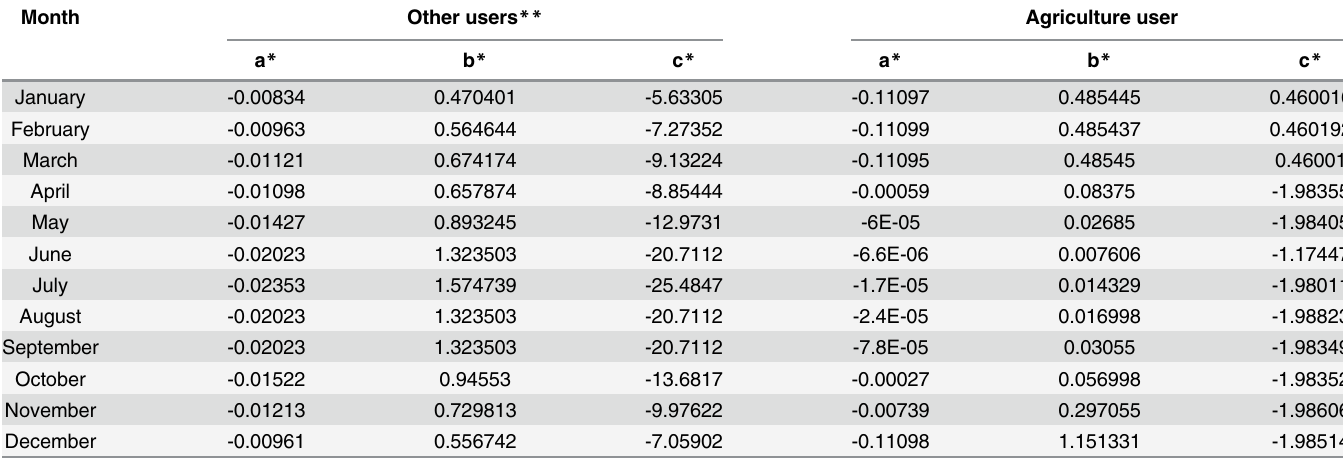
Table 1. The coefficients of the quadratic equations of utility values for different water